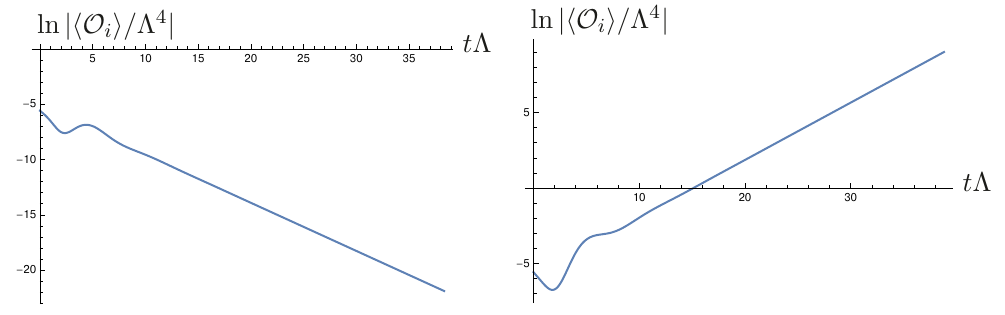
Figure 12 . Linearized dynamics of the symmetry breaking expectation value (left panel) and